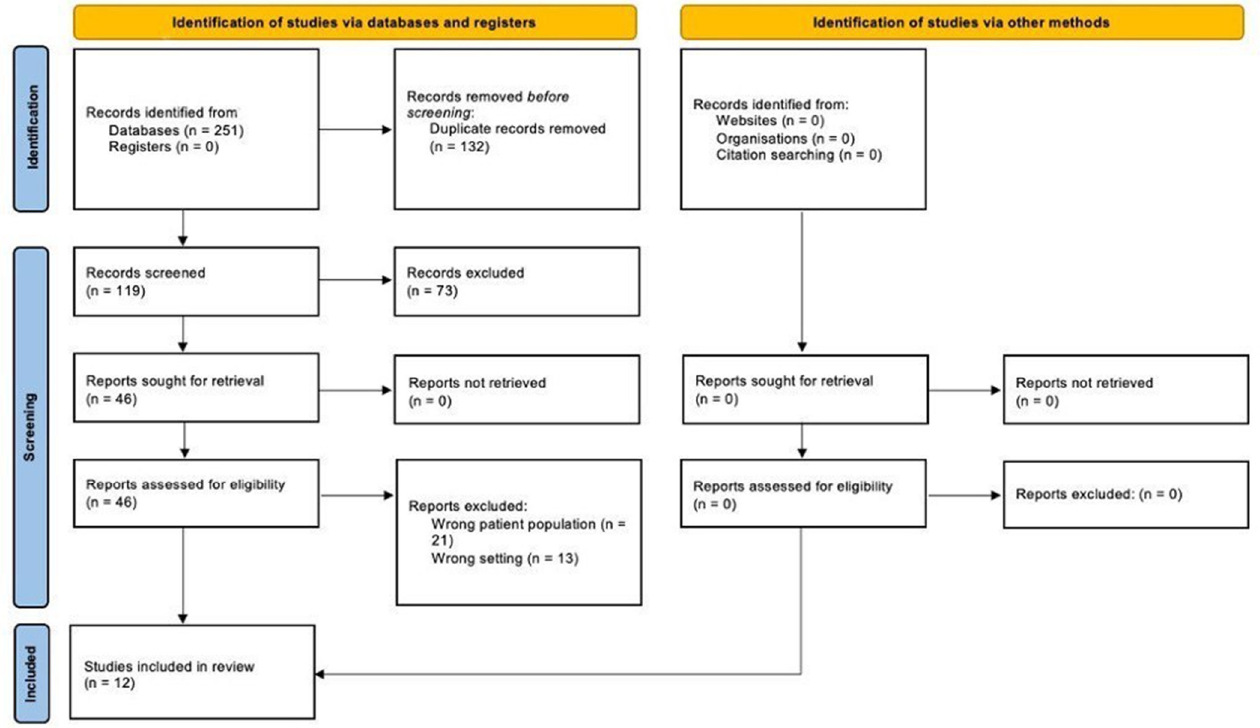
Figure 1. PRISMA flow diagram of this systematic review.